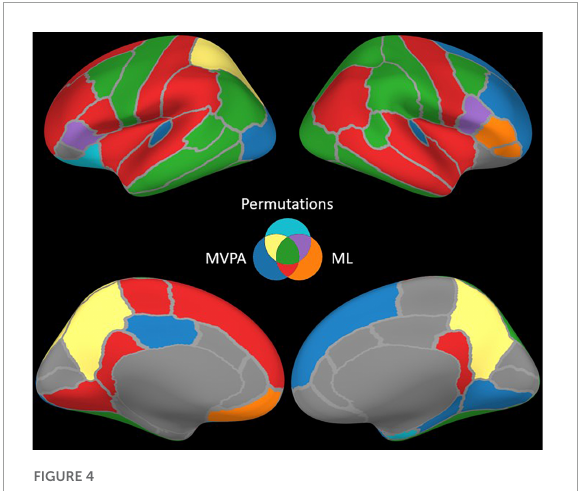
FIGURE4 Brain structures with significant contrasts revealed by one or more methods.